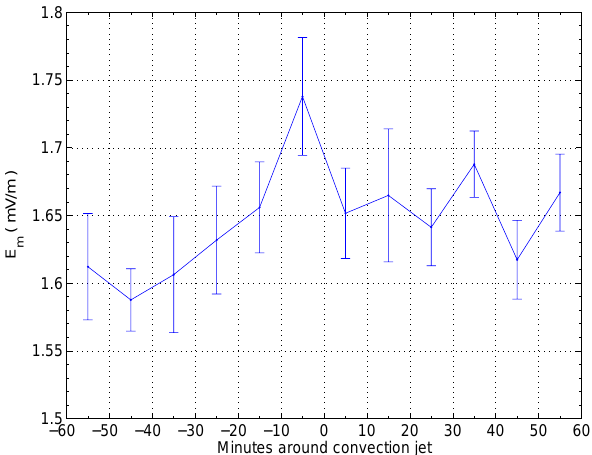
Fig. 7. Seasonal variation of the peak convection jet velocity value (blue) and | d6 P /d MLat | (green). Monthly means are